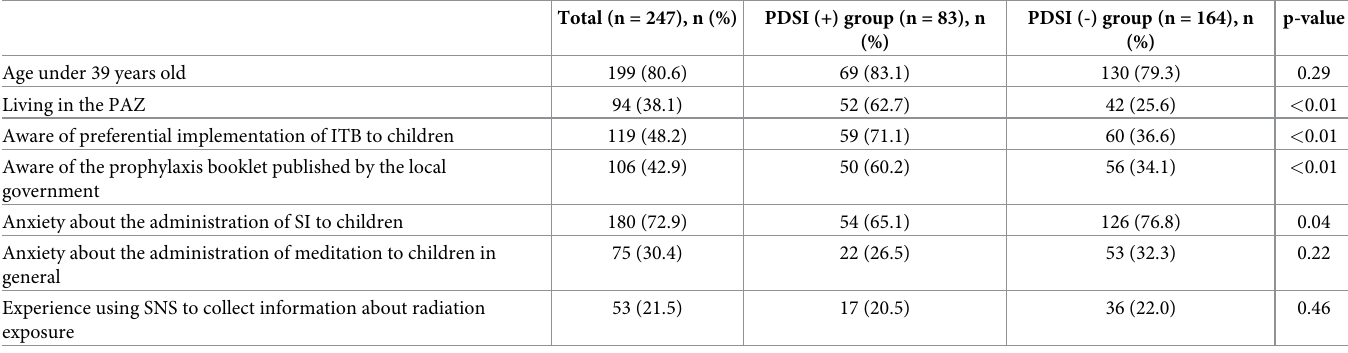
Table 1. Characteristics of the